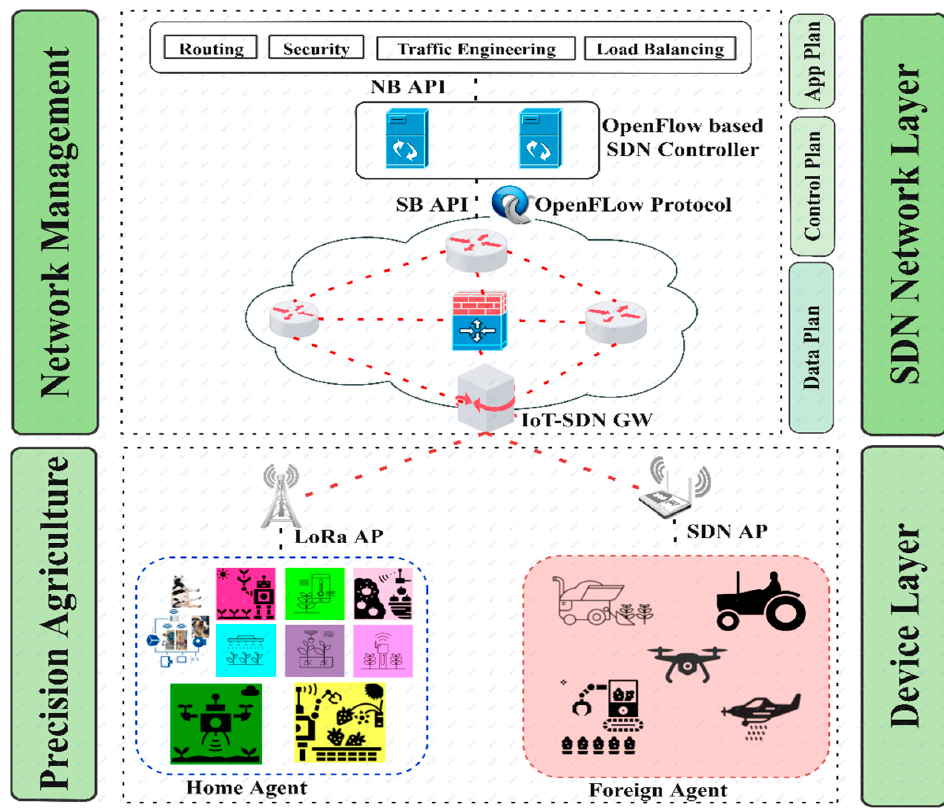
Figure 1. System workflow of the proposed framework.